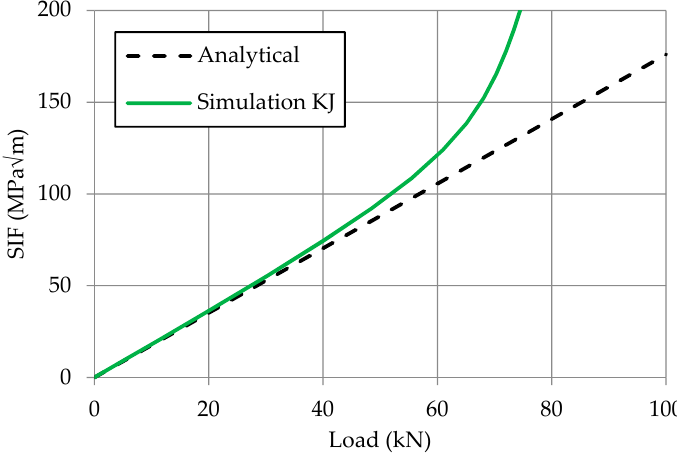
Figure 8. Comparison of K J with the analytically calculated stress intensity